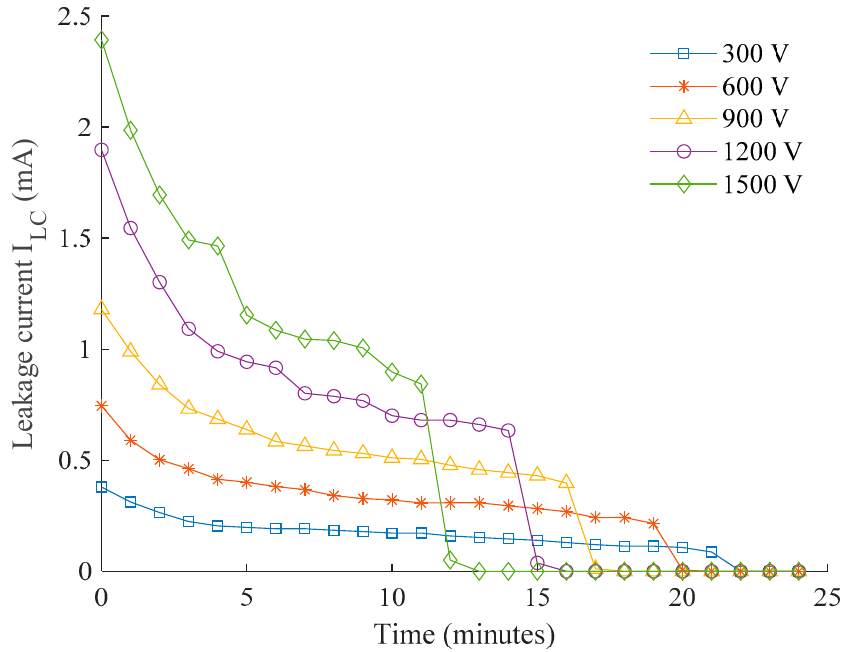
Figure 7. The plot of leakage current for different energization voltages during a period of testing.